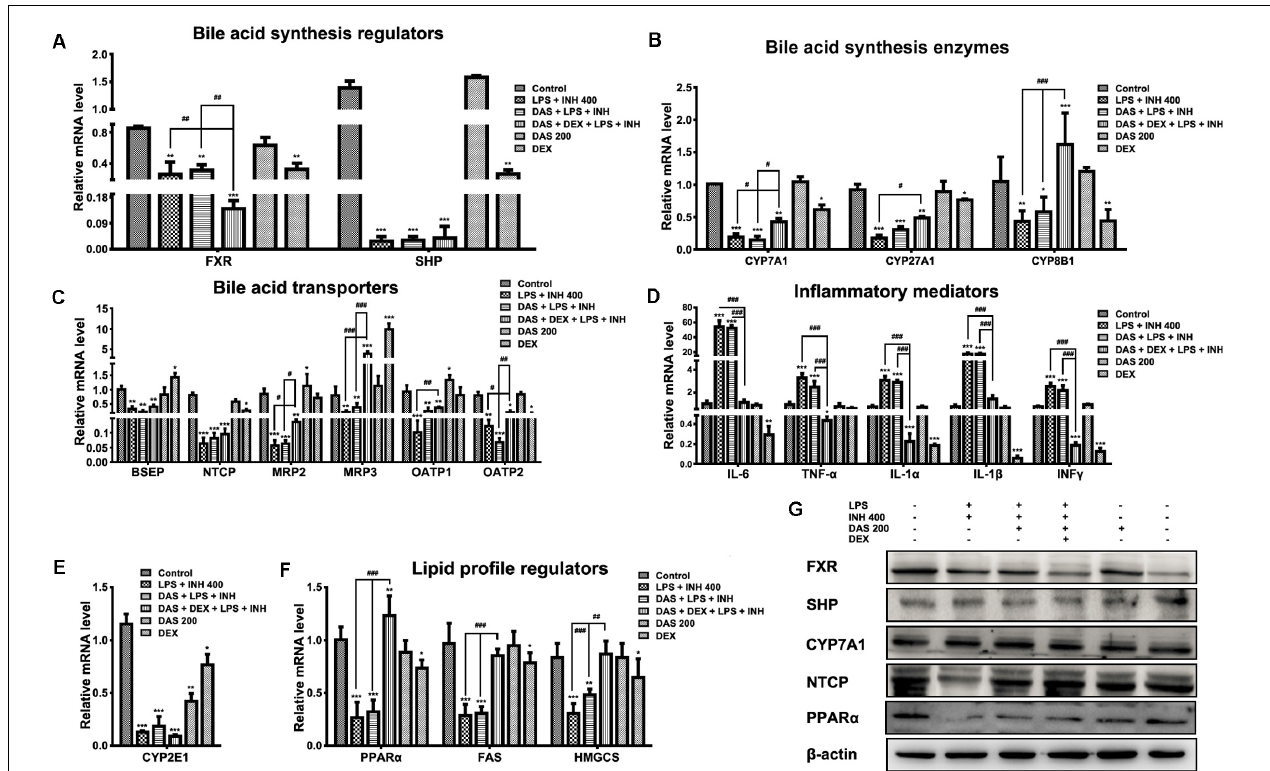
FIGURE 5 | Changes in different targets’ genes and proteins expressions following INH/LPS treatment with or without DAS and DEX. (A) Bile acid regulators FXR and SHP expression. (B) Expression of bile acid synthesis enzymes CYP7A1, CYP27A1, and CYP8B1. (C) Bile acid transporters BSEP, NTCP, MRP2, MRP3, OATP1, and OATP2 expression. (D) Inflammatory mediators IL-6, TNF α , IL-1 α , IL-1 β , and INF γ expression. (E) Expression of CYP2E1. (F) Lipid profile regulators PPAR α , FAS, and HMGCS expression. Data were represented as mean ± SD, n = 7 for each bar. ∗ P < 0.05, ∗∗ P < 0.01, ∗∗∗ P < 0.001 versus control, # P < 0.05, ## P < 0.01, ### P < 0.001 versus INH/LPS or DAS/INH/LPS combination, GAPDH was set as reference control gene. (G) Immunoblotting analysis of different targeted proteins following INH/LPS with or without DAS and DEX treatment, β -actin considered as loading